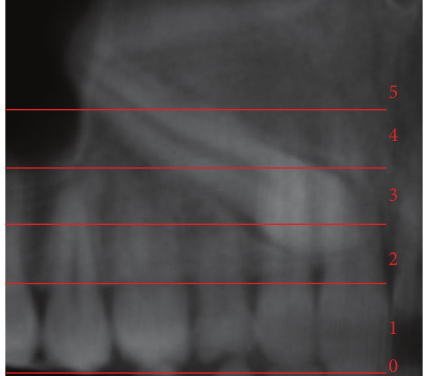
Figure 1: Mesiodistal position (𝑥) for both cusp and root tips; Pan- orex view. In this example 𝐶 𝑥 = 5 and 𝑅 𝑥 = 5 .